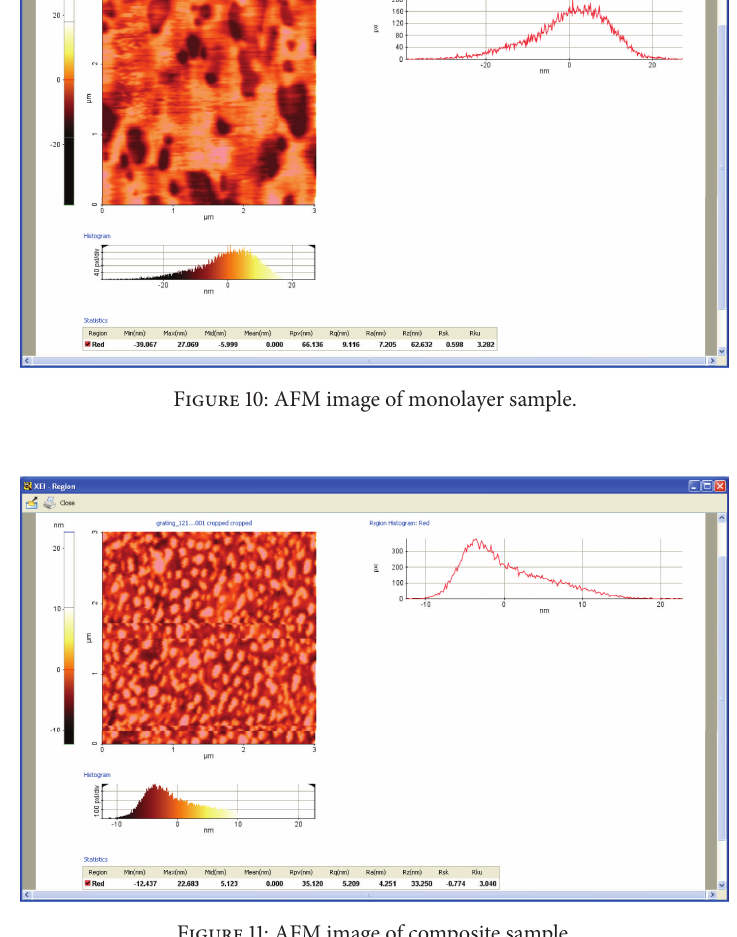
Figure 11: AFM image of composite